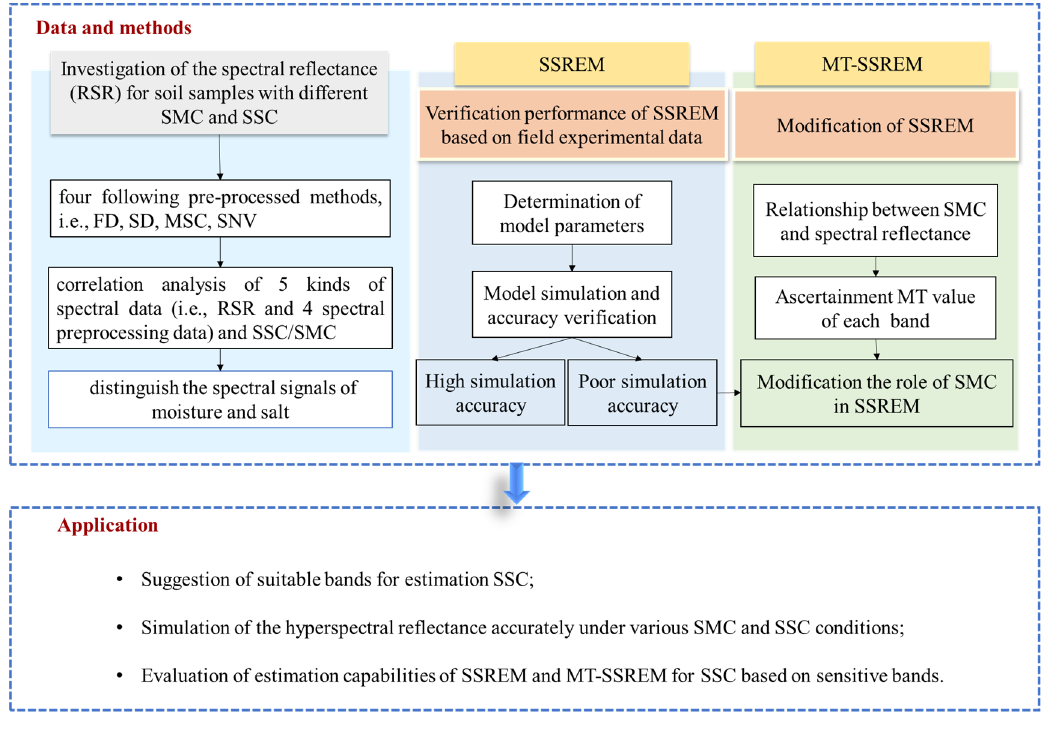
Figure 2. Study framework. Note: RSR is raw reflectance spectra reflectance; SSREM is the soil spectral reflectance exponential model; MT is the moisture threshold; MT − SSREM is the modified model based on SSREM considering MT; FD is the first derivative of RSR; SD is the second derivative of RSR; MSC is the multiplicative scatter correction of RSR; SNV is the standard normal variate transform of RSR.